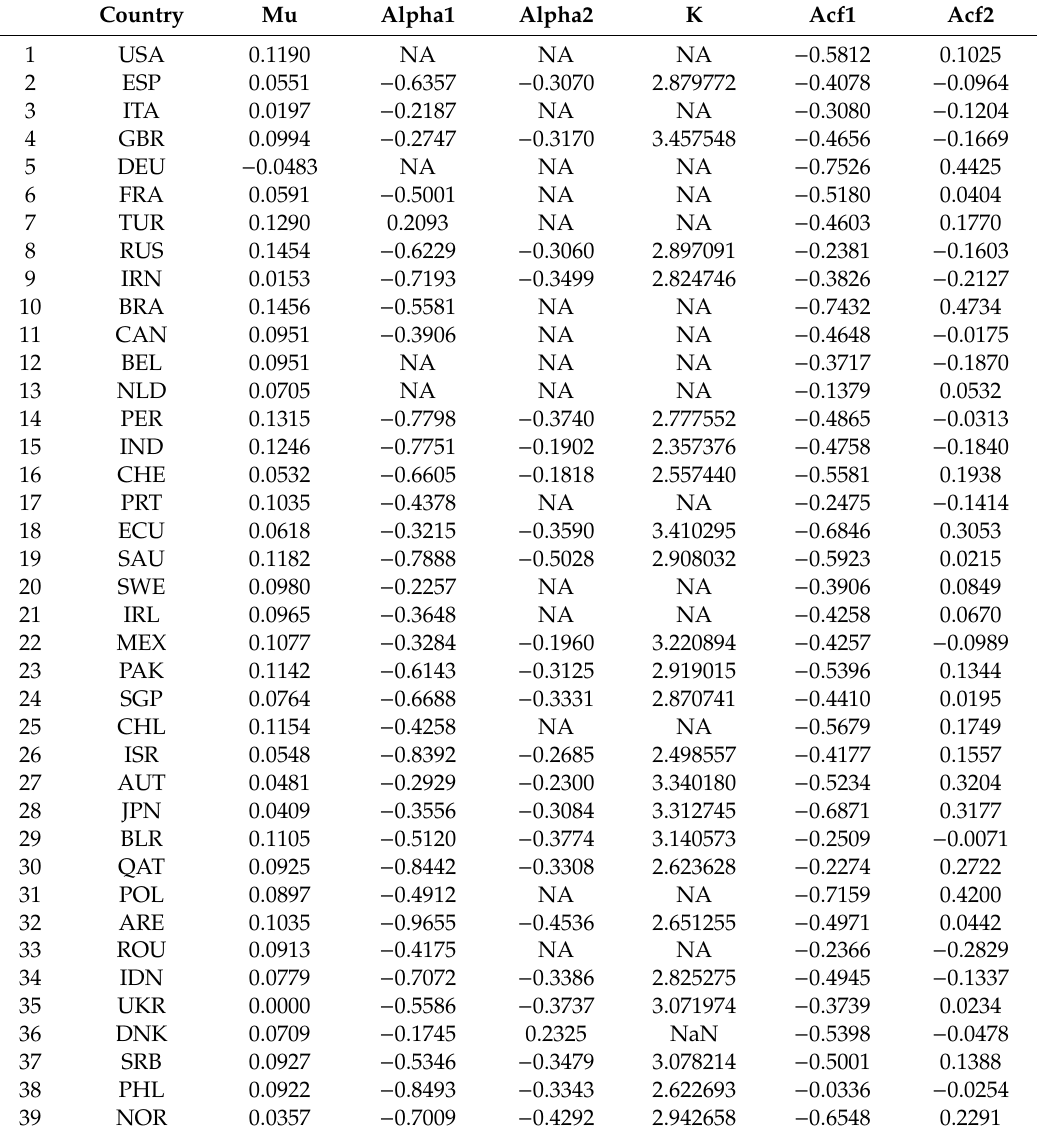
Table A1. Estimation results for the univariate AR( p )